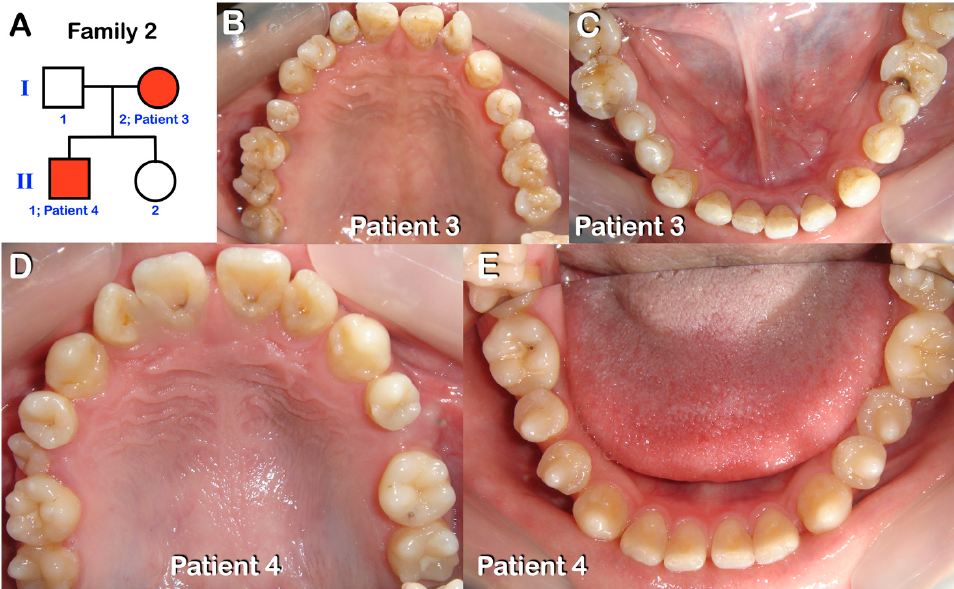
Figure 3. Family 2. ( A ) Pedigree of family 2. Patients 3 and 4. ( B , C ) Patient 3 and ( D , E ) Patient 4. Both are in permanent dentition. Round-shaped permanent molars, molars with multiple supernumerary cusps, and premolars with single prominent cusps.